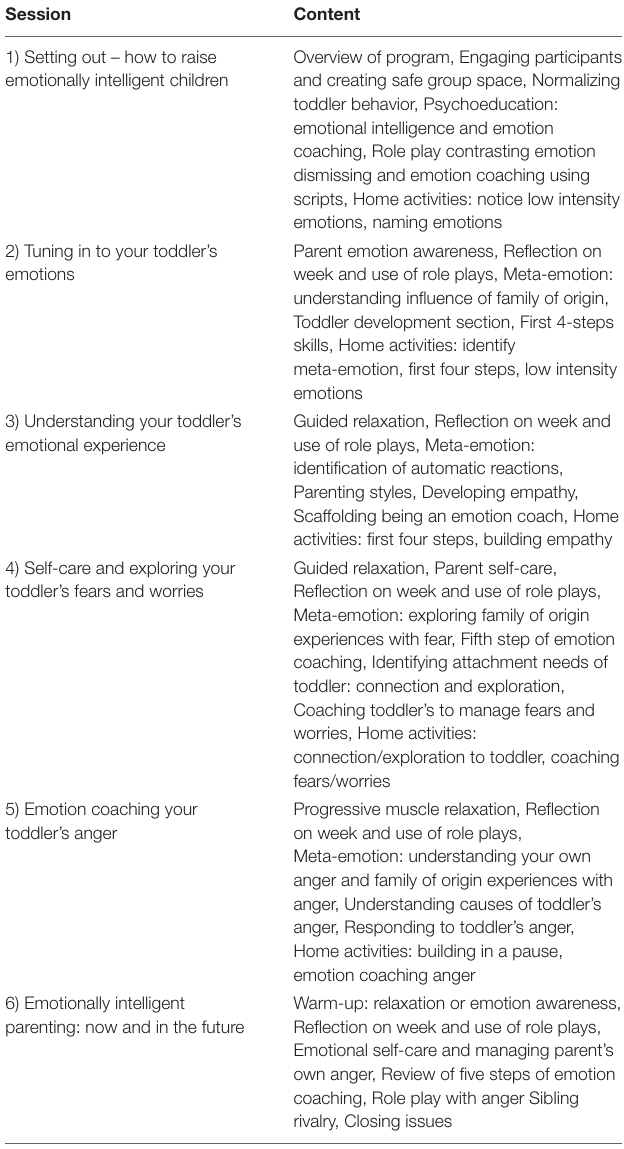
TABLE 1 | TOTS program